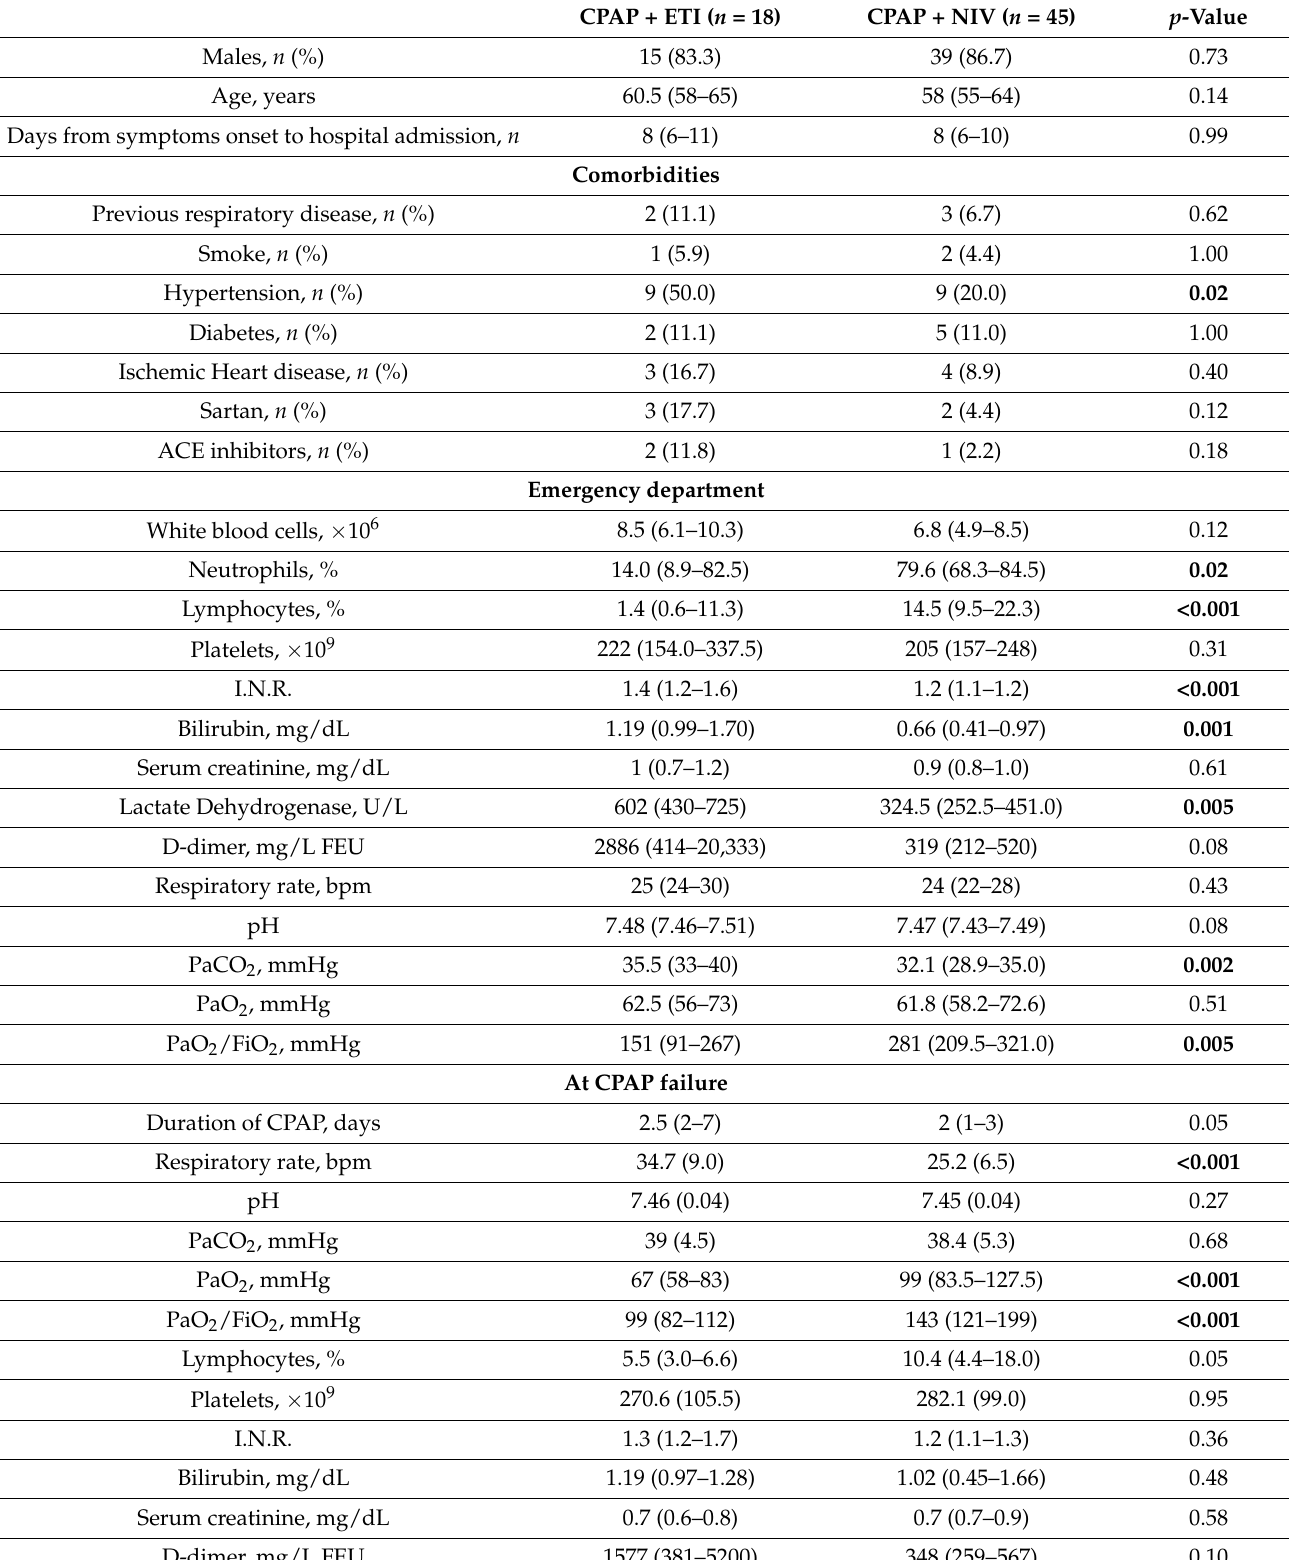
Table 2. Clinical characteristics and outcomes in patients that failed CPAP and were intubated or undergone a NIV